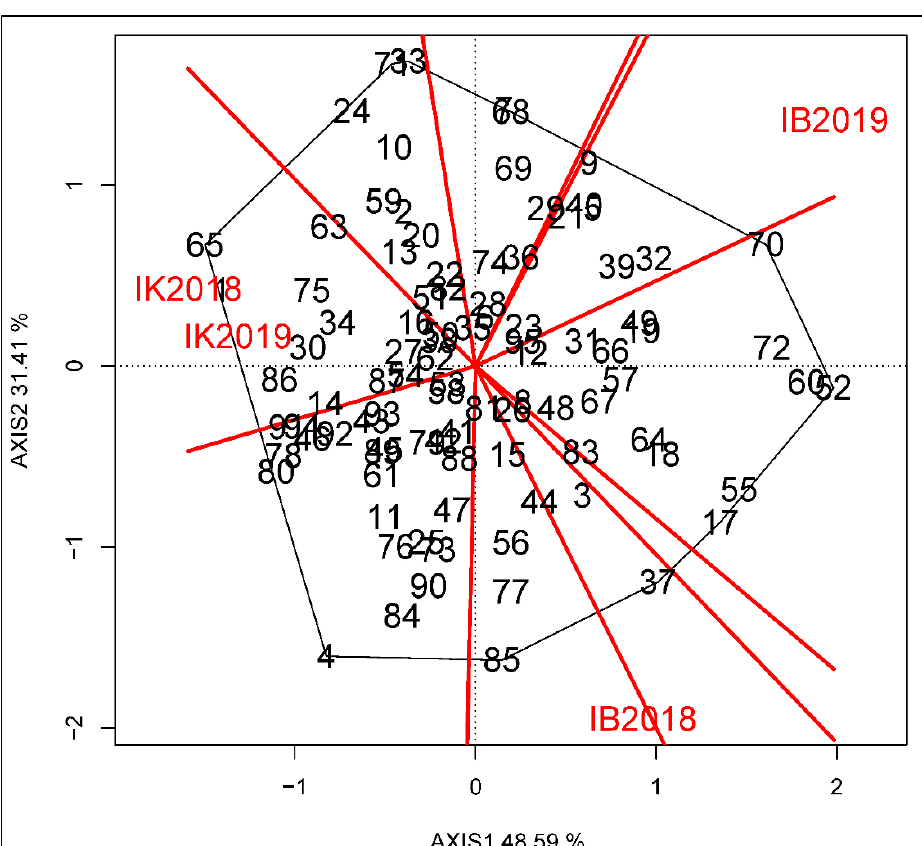
Figure 4. Which-won-where analysis of the accessions. Identifying the best accessions suitable for each test environment.